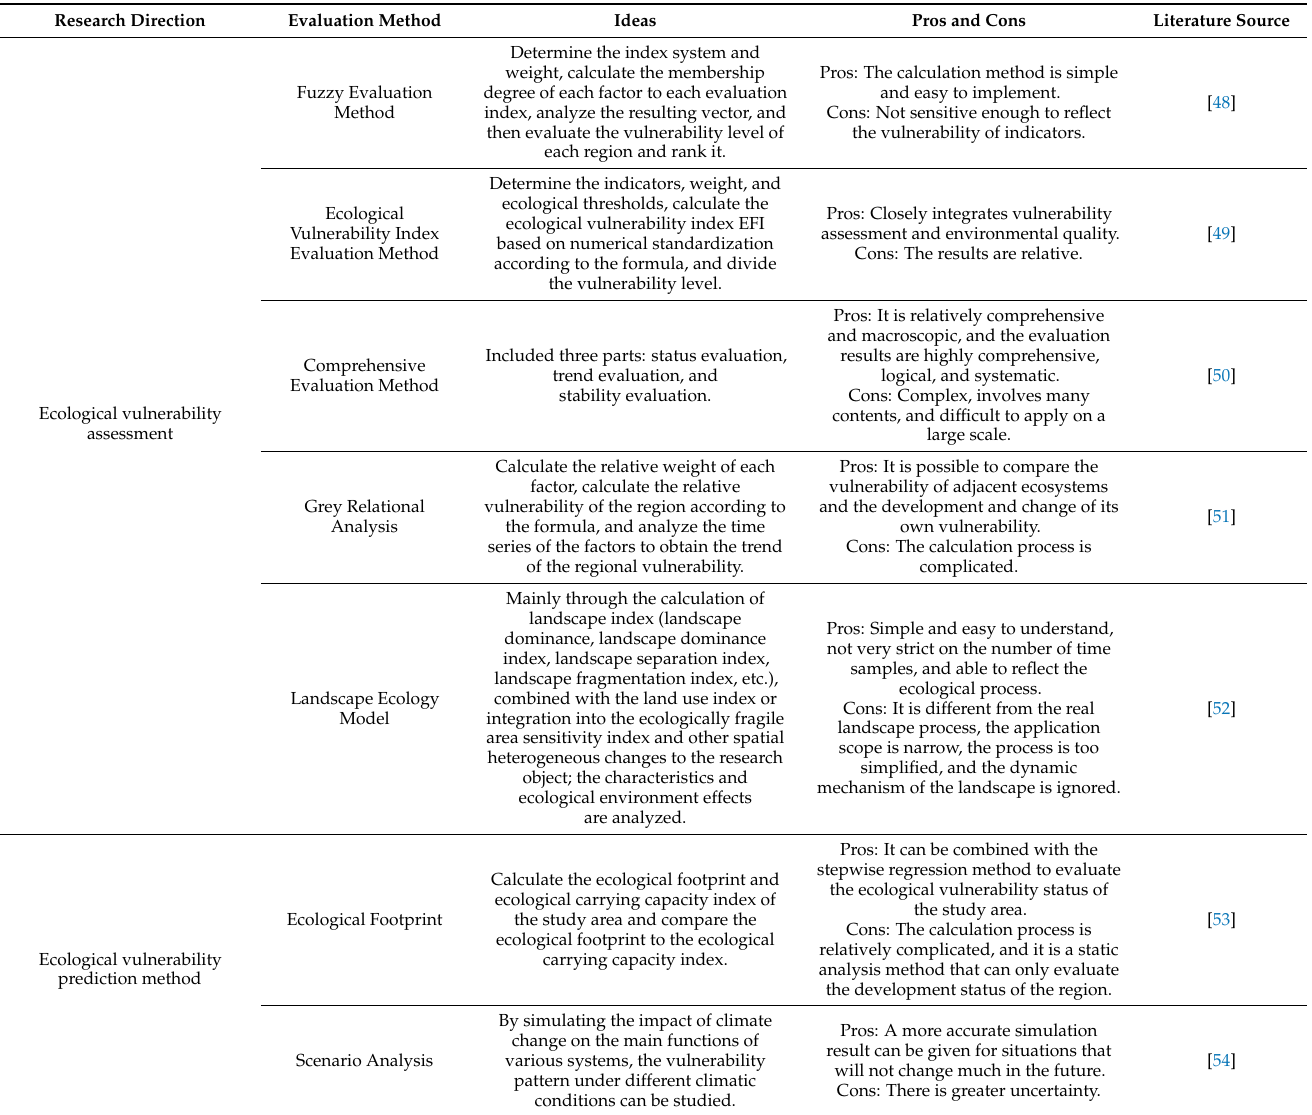
Table 2. Ecological vulnerability assessment